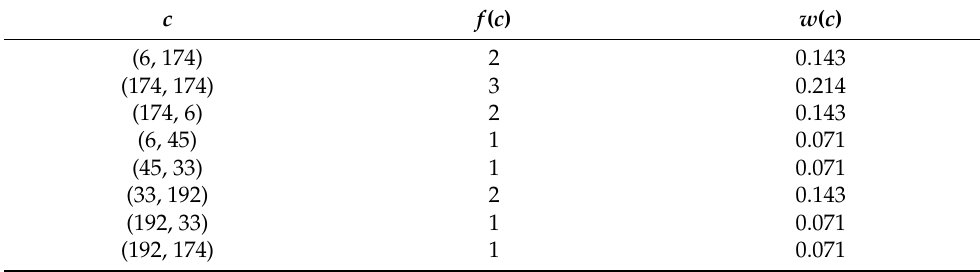
Table 7. The weights and frequencies of all